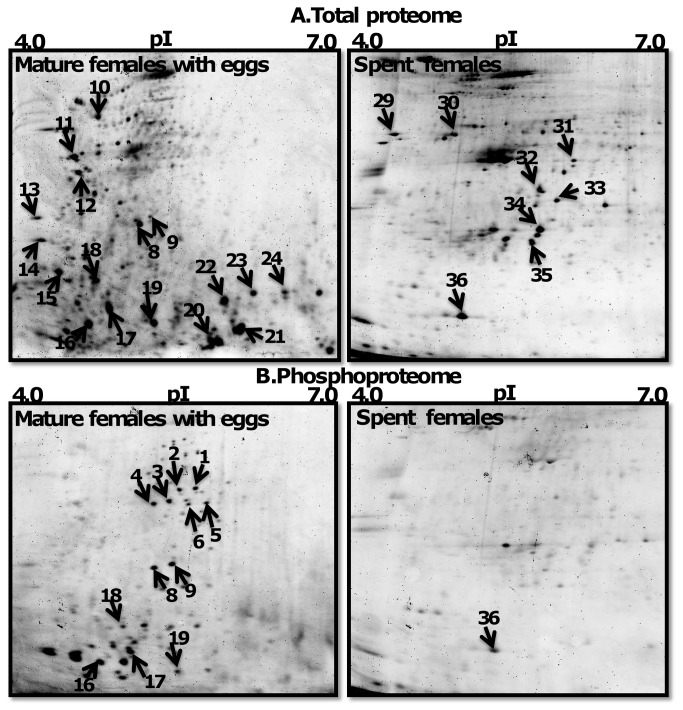
Proteome of mature females and spent females.2DE gels stained with Sypro Ruby dye to detect total protein (upper panel) and Pro-Q Diamond dye to detect phosphoproteins (lower panel). Protein spots marked with arrow were identified by mass spectrometry.